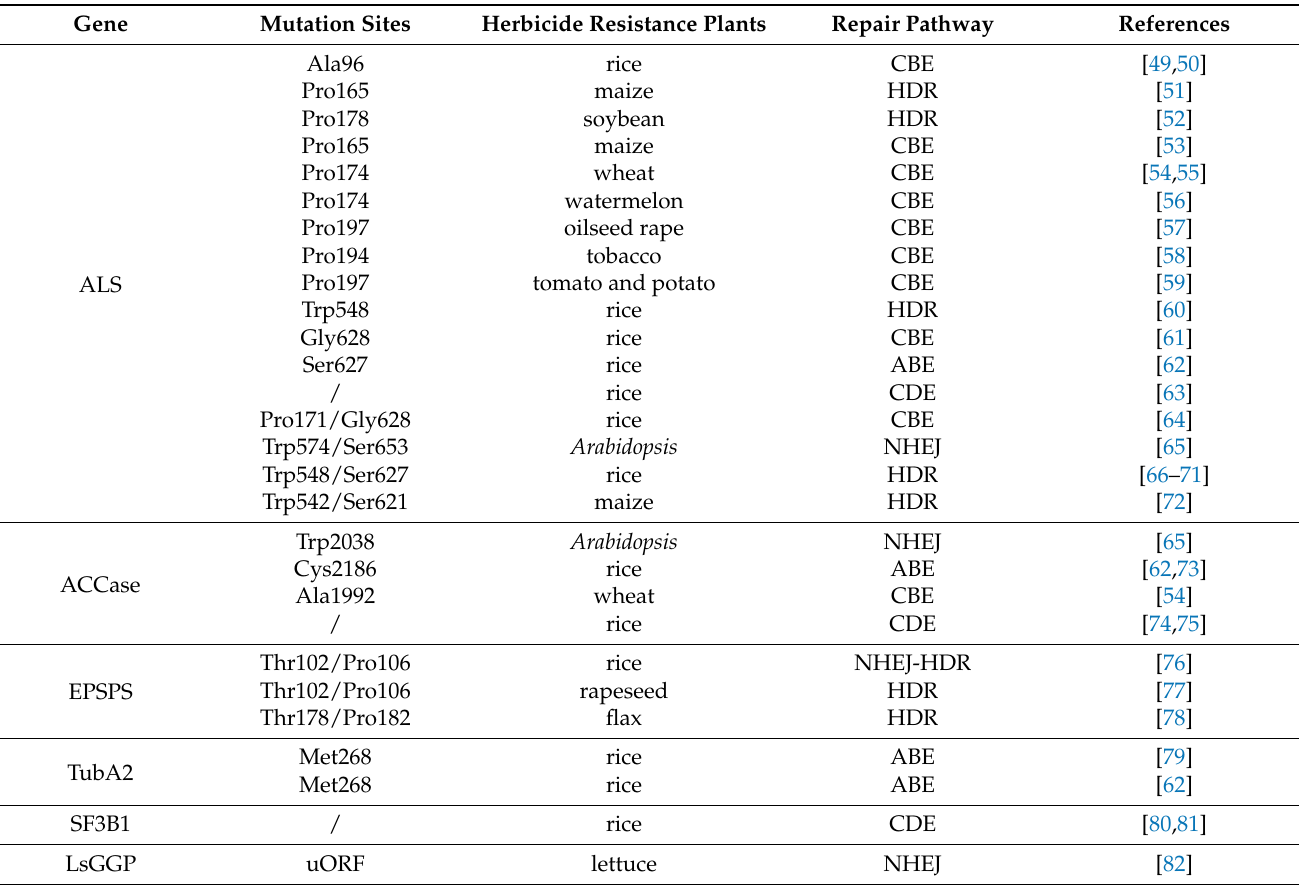
Table 1. The herbicide-resistant plants generated by CRISPR/Cas9-mediated gene editing. Gene Mutation